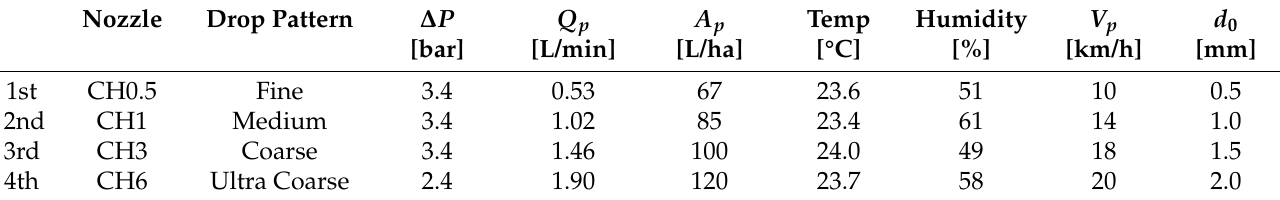
Table 1. Experimental setup for the ASDS using full cone nozzles (Magnojet ®